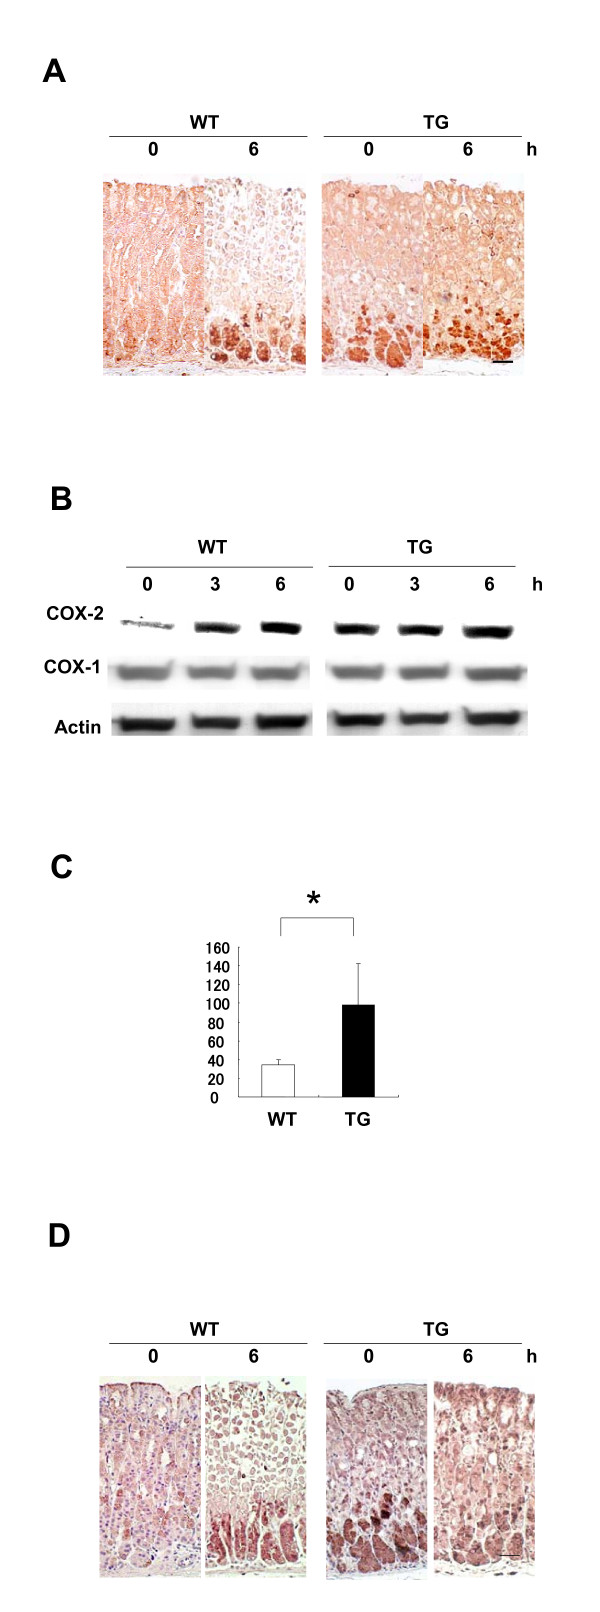
COX-2 and NFκB expression in the gastric mucosa. (a) Immunostaining of COX-2. COX-2 was intensively induced after the injury at the lower glandular region of the WT mucosa, whereas it was constitutively expressed in the same region of the TG mucosa even before the injury. Ethanol-injured mucosa was stained 6 h after the ethanol administration. Scale: 100 μm. (b) Immunoblotting of COX-2 and COX-1. The blots were measured 0, 3, and 6 h after the injury. Actin filaments were used as a control. Note that COX-2 was intensively expressed before the injury in the TG mucosa. (c) Measurement of prostaglandin E2. Prostaglandin E2 levels were measured before the ethanol treatment in the WT and TG mucosae. n = 5, p = 0.013. (d) Immunostaining of NFκB. NFκB was intensively induced after the injury at the same lower glandular region of the WT mucosa as was COX-2. In contrast, NFκB was constitutively expressed in the same region of the TG mucosa even before the injury. Scale: 100 μm.